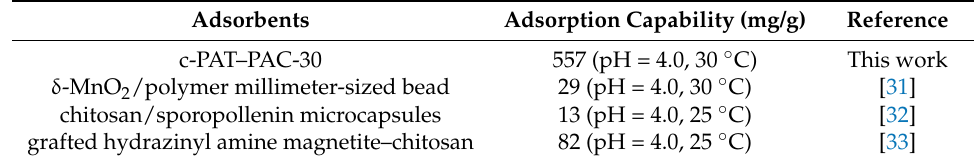
Table 2. The comparison of adsorbents toward Ni(II) adsorption reported from the literature.